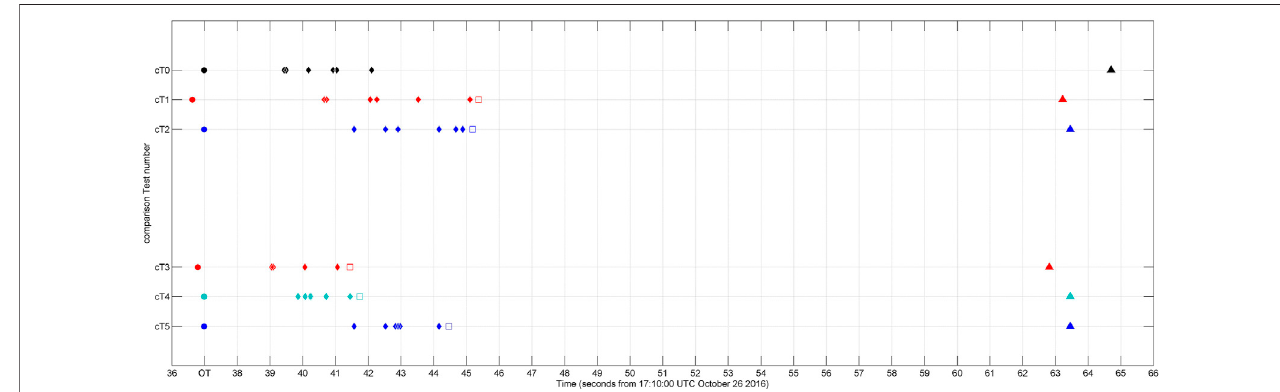
FIGURE 4 | Comparison of arrival times relative to Mw 5.4 October 26, 2016 earthquake. Circles: Origin Time. Diamonds: P phase arrival times of the triggered stations. Squares: TFA. Triangles: S phase arrival times at INGV_AN target in city of Ancona (88 km epicentral distance). cT0: arrival times of human event revision. cT1: PRESTo real time instance with PSN15. cT2: EDS with real latency and with PSN15. cT3: PRESTo playback instance with PSN15 and TSN16. cT4: EDS with zero latency and PSN15 + TSN16. cT5: EDS with real latency with PSN15 +